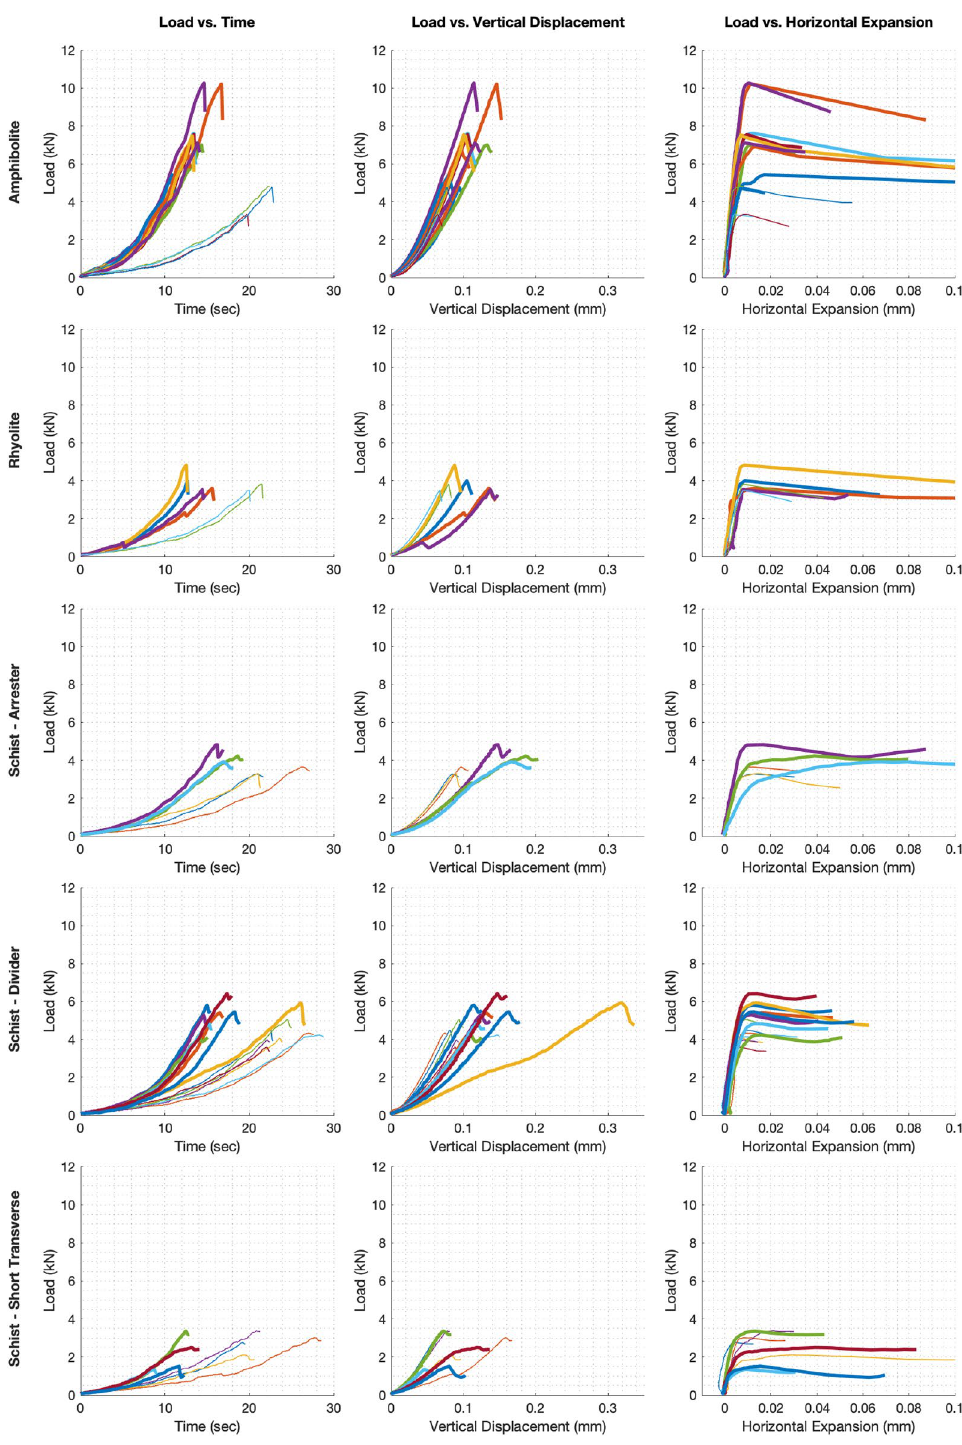
Figure 4. Results from fracture toughness loading tests. Rows, from top to bottom: amphibolite, rhyolite, schist–arrester, schist–divider, schist–short transverse. Bold and thin curves indicate samples loaded at rates of 20 μm/s and 10 μm/s,